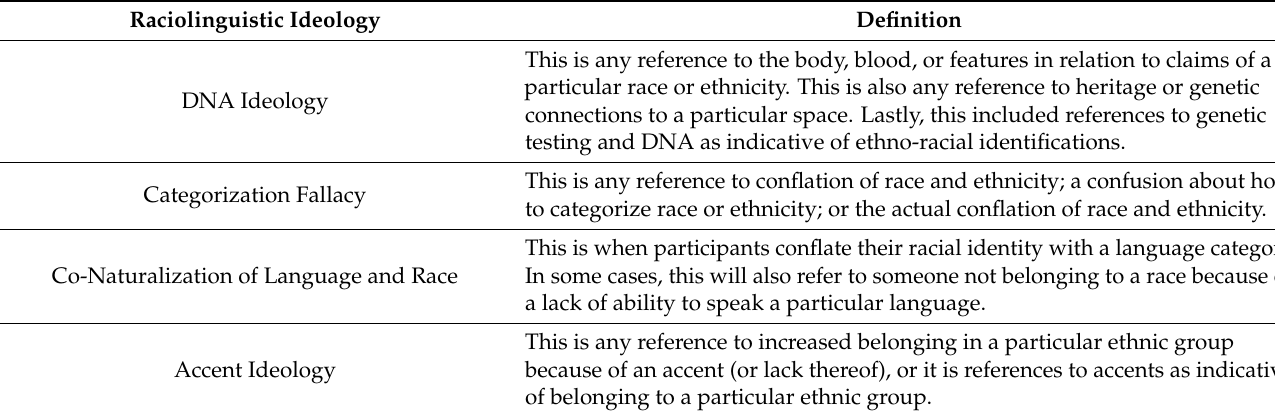
Table 1. Focal raciolinguistic